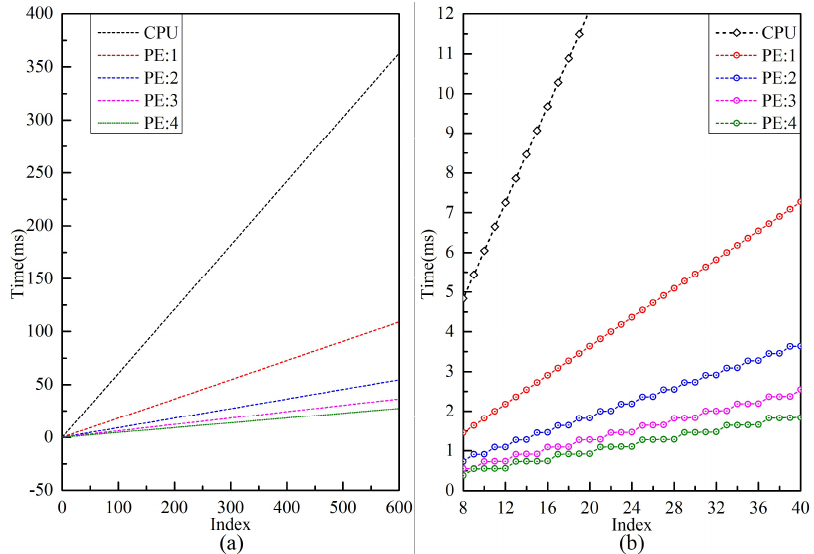
Figure 10. Time consumption graphs of CPU and PE: ( a ) time consumption of processing 600 sets; ( b ) partially enlarged view time consumption of processing 600 sets.